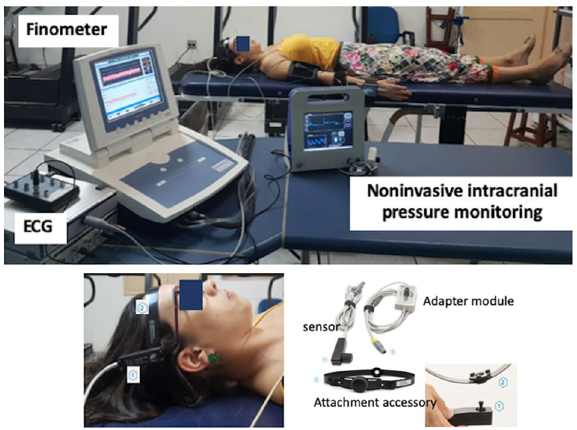
Figure 1. Illustration of the data collection and the positioning of the extracranial